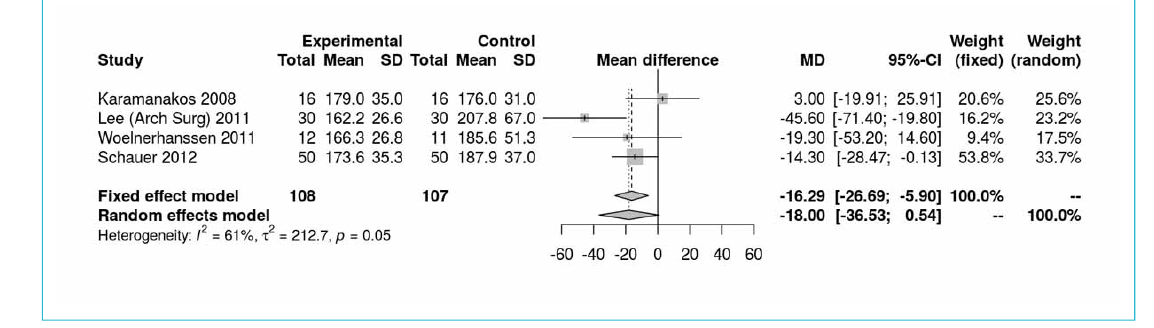
Figure S4b: Cholesterol at 12